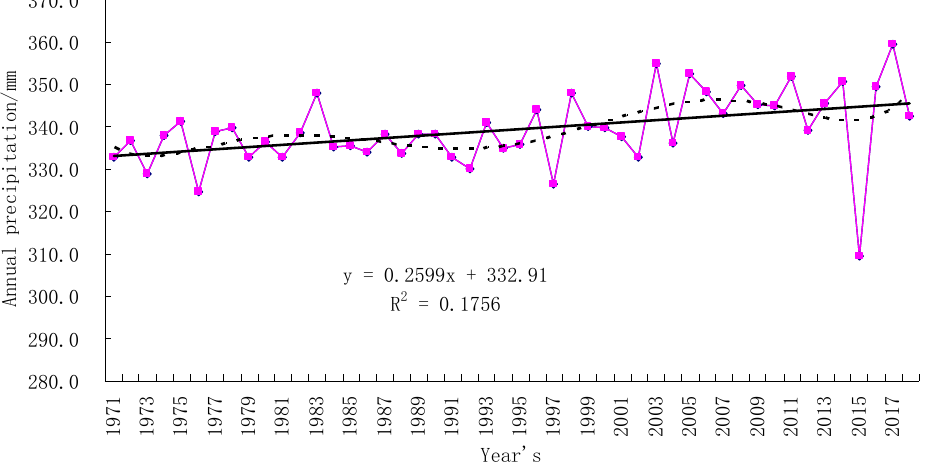
y = 0.2599x + 332.91 R 2 = 0.1756